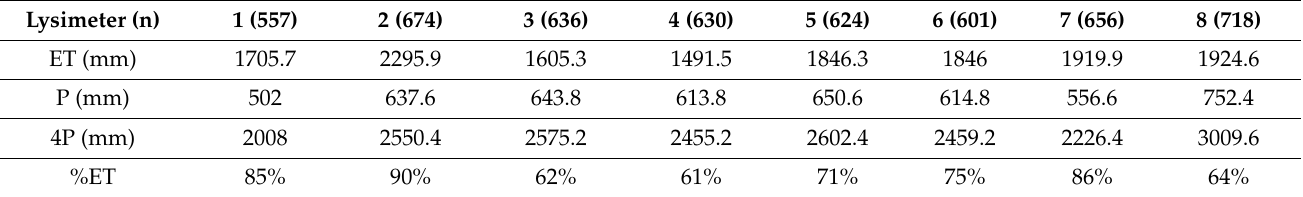
Table A3. Proportions of evapotranspiration (ET) to the rainfall (4P) received in each lysimeter. The number of data (n) refers to the common validated data between the rainfall and the considered ET of the lysimeter (on a total of 1096